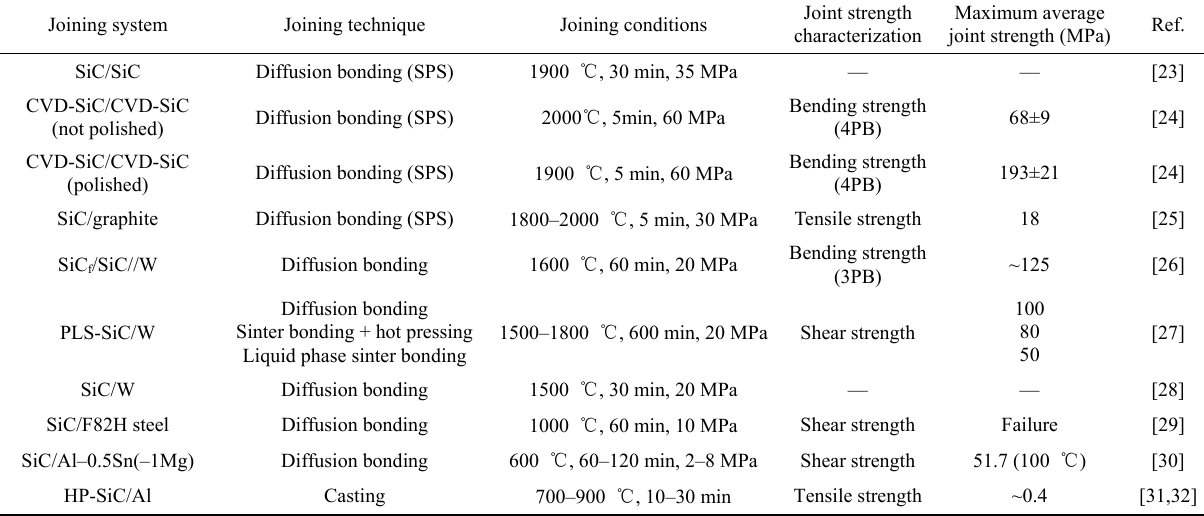
Table 1 Joining of SiC-based materials using no interlayer: joining technique, joining conditions, and joint strength Joining system